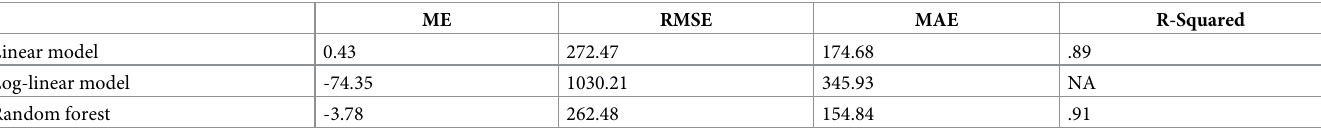
Table 3. Performance statistics for candidate